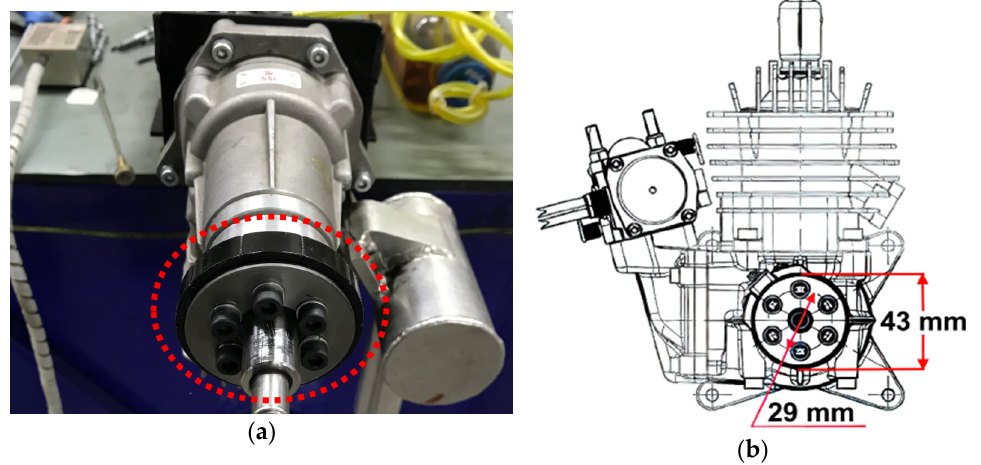
Figure 4. Mounting illustration of the ( a ) Inner rotor; ( b ) Inner flange.